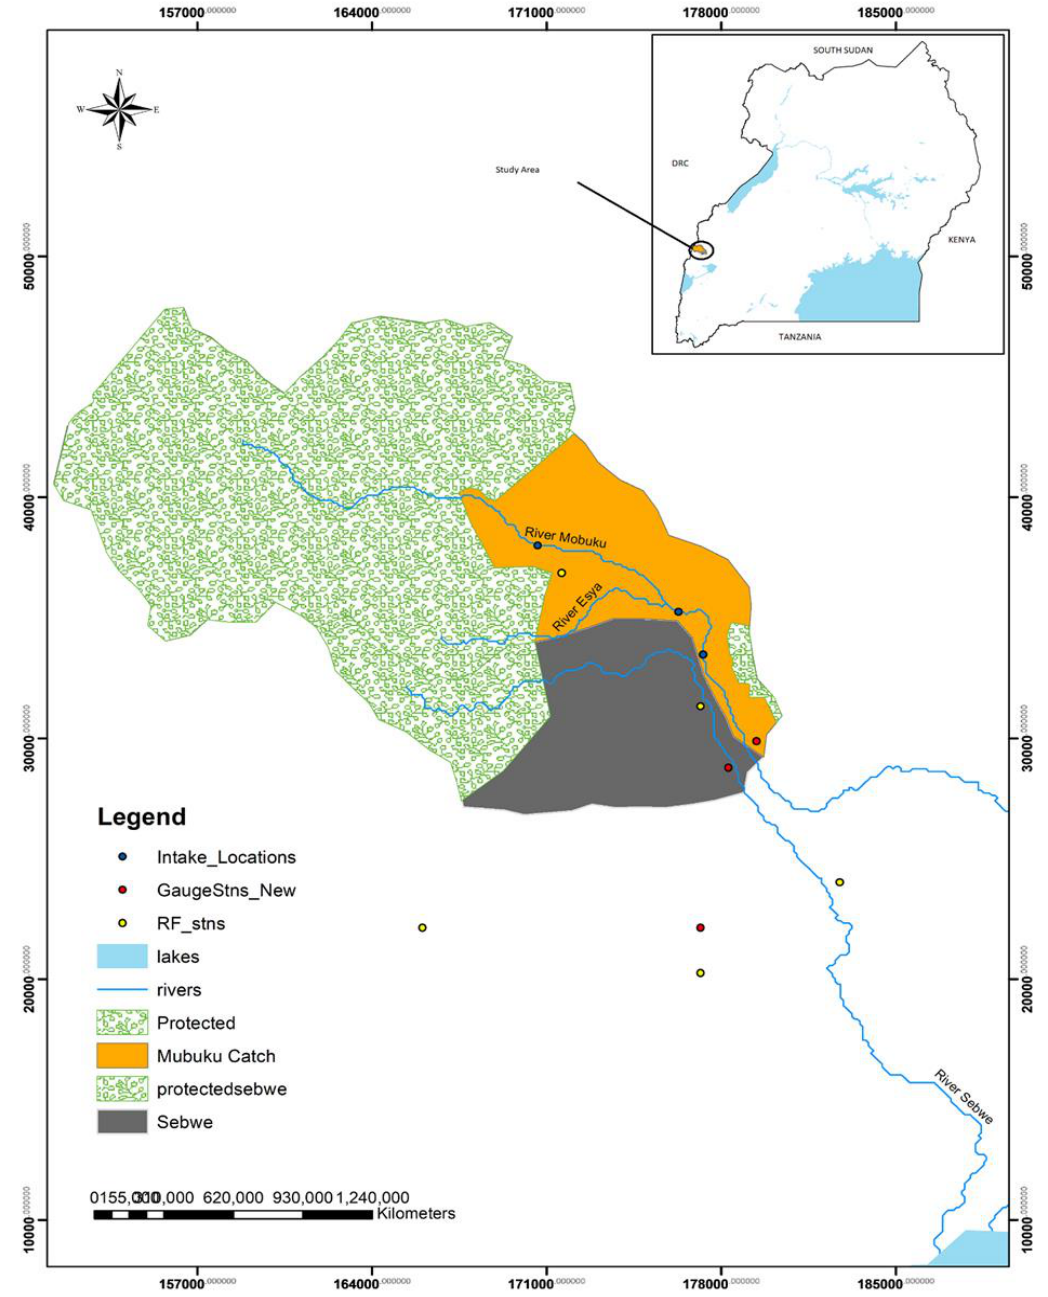
Figure 1 . Location of Mubuku-Sebwe Sub-catchments . Figure 1. Location of Mubuku-Sebwe